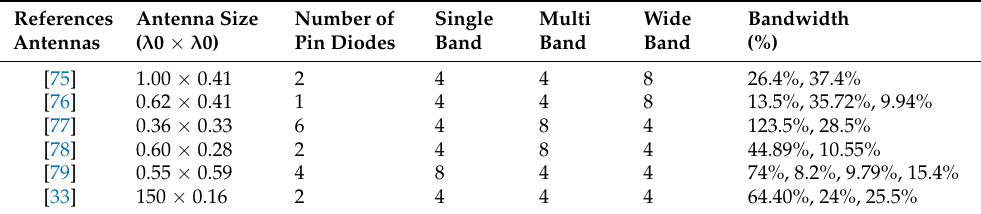
Table 3. Comparison of different antennas using pin diode as a witching component. References